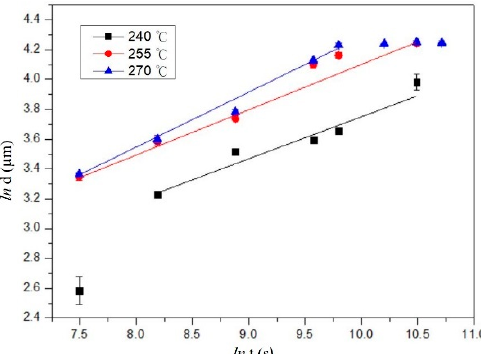
Figure 9. The plot of ln t vs. ln d of Cu 6 Sn 5 phase at different reaction temperatures in the SC/C194 reaction couple. Table 3. The n values of the Cu 6 Sn 5 phase at different reaction temperatures in the SC/C194 reaction couple.